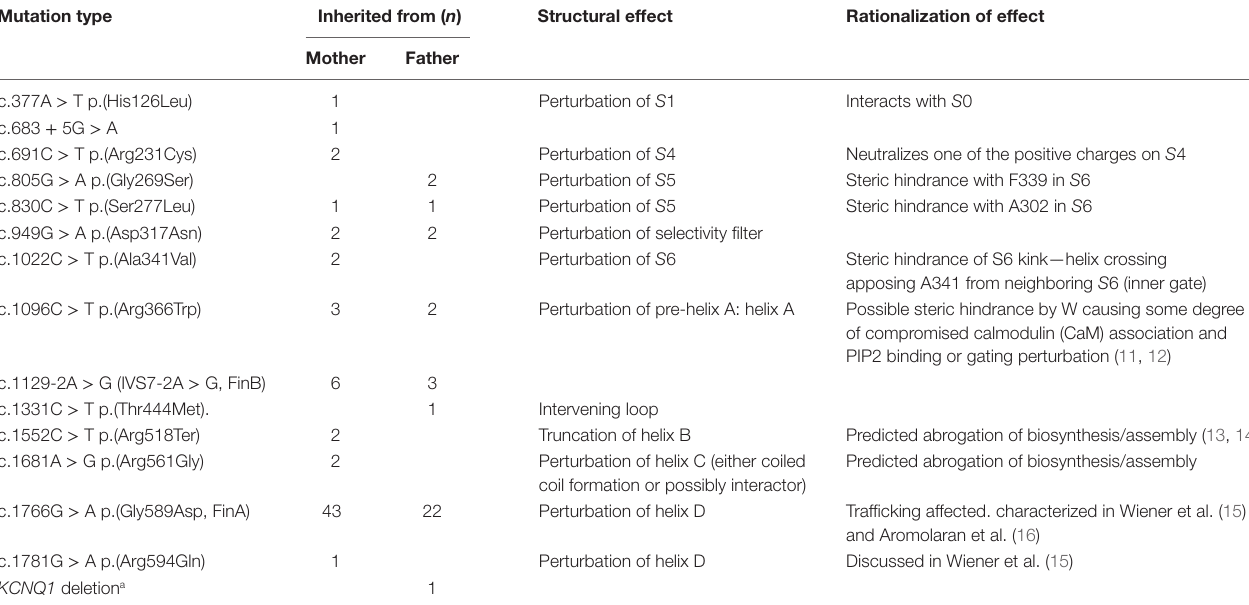
TaBle 1 | Molecular genetic diagnoses of long QT syndrome 1 (LQT1) patients and the structural and rationalized effects of the mutant proteins.